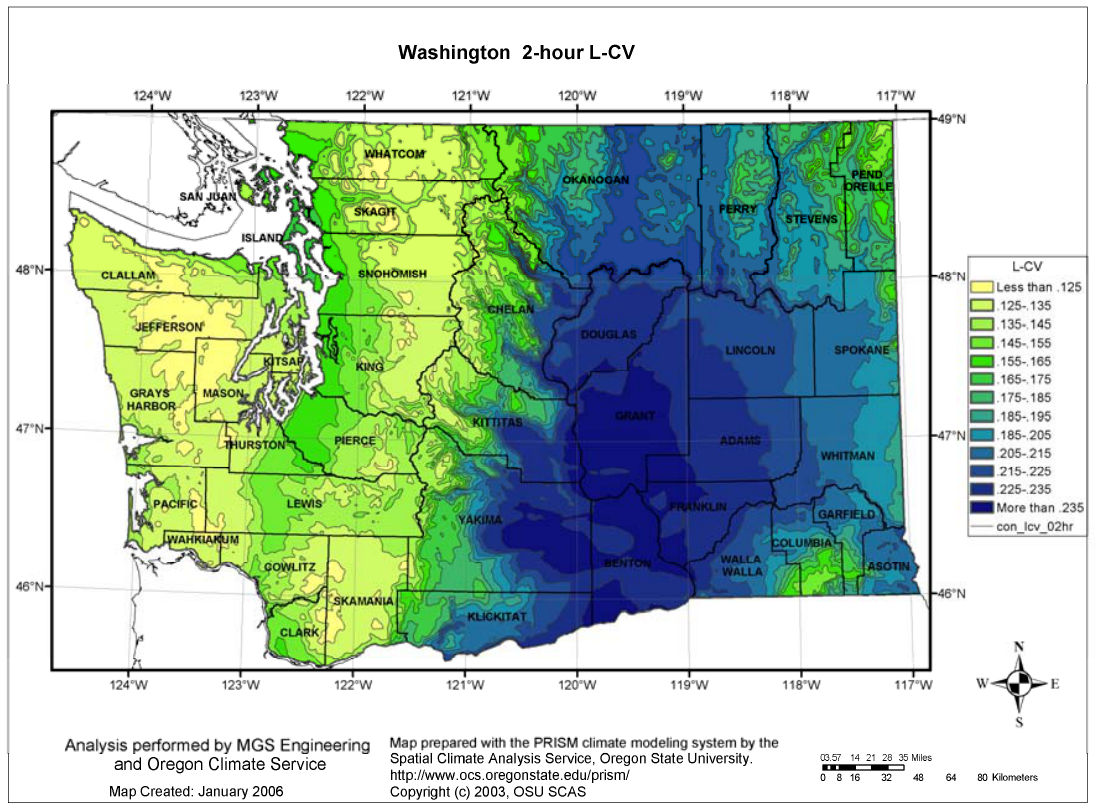
Fig. 19. Statewide variation of L-Cv annual maximum precipitation at 2-hour